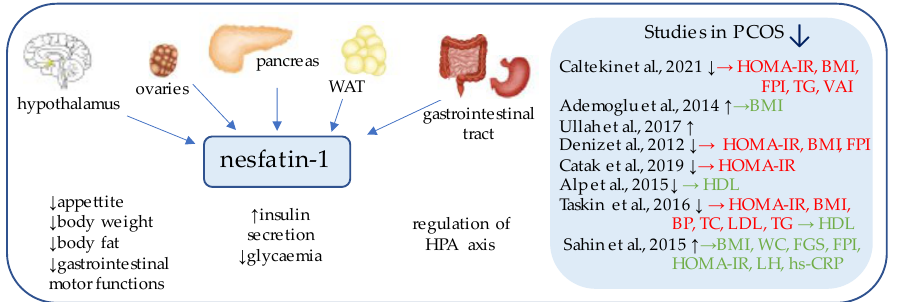
Figure 1. Role of nesfatin-1 in the pathogenesis of insulin resistance and PCOS. List of the studies assessing serum nesfatin level in the PCOS patients. ↑ / ↓ indicates whether concentration level of serum nesfatin was increased/decreased in PCOS individuals ( p < 0.05); → (green)—indicates positive correlation between serum nesfatin and particular indicators; → (red)—indicates negative correlation between serum nesfatin and particular indicator; HOMA-IR—Homeostatic Model Assessment for Insulin Resistance; BMI—body mass index; FPI—fasting plasma insulin;